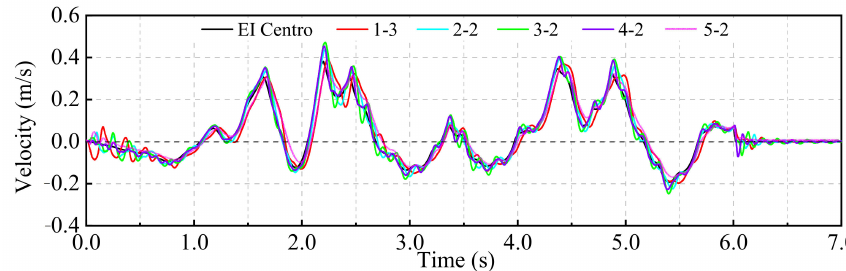
Figure 15. Horizontal velocity time history curve of monitoring points in the bedrock.